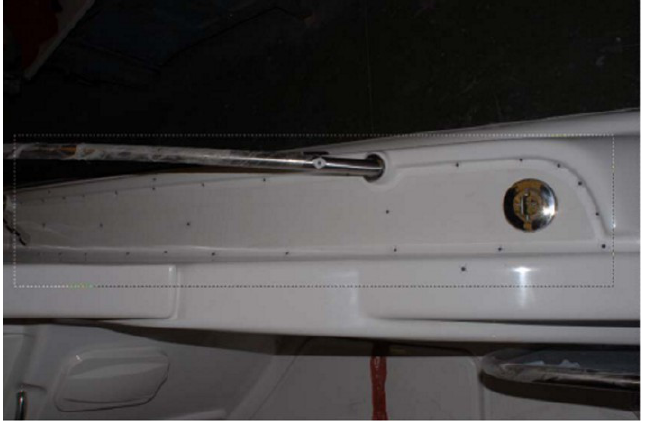
Figure 3. Targets located on straight and curved lines on a